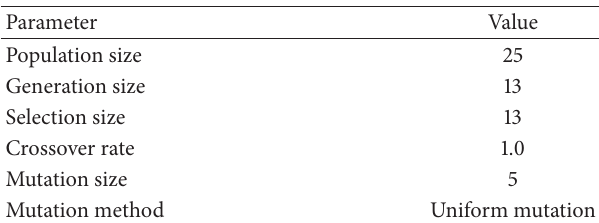
Table 1: Experimental